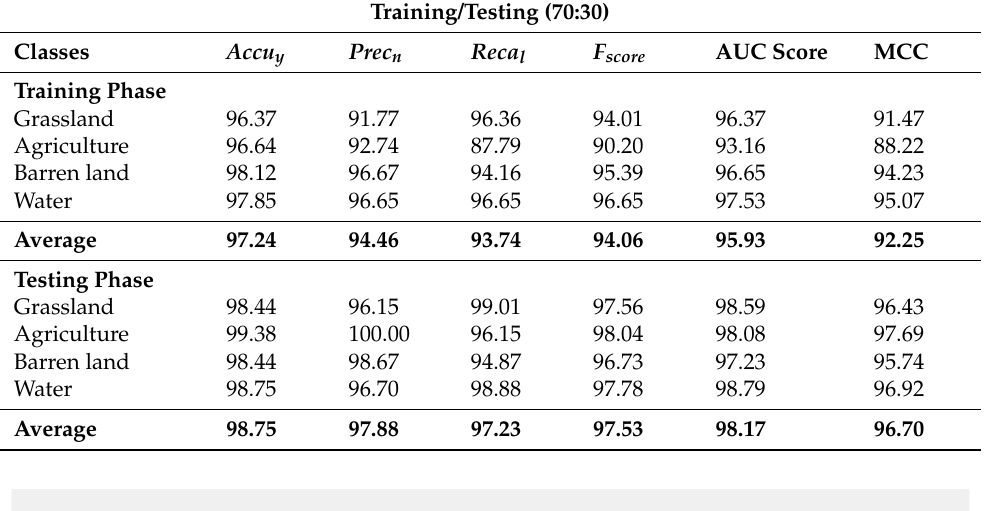
Table 3. Classification outcome of TSADL-LULCCD approach on 70:30 of TR/TS databases.